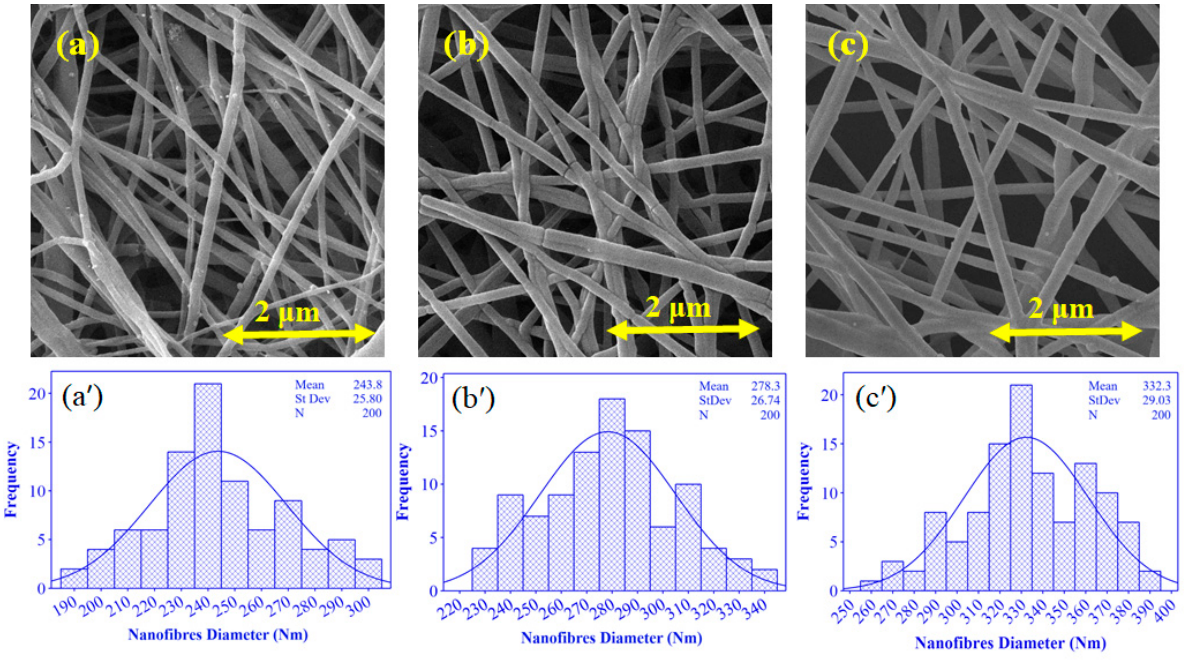
Figure 8. SEM images and histograms of ( a , a ′ ) PEO 3% GE 10% , ( b , b ′ ) PEO 4% GE 10% , and ( c , c ′ ) PEO 5% GE 10% .